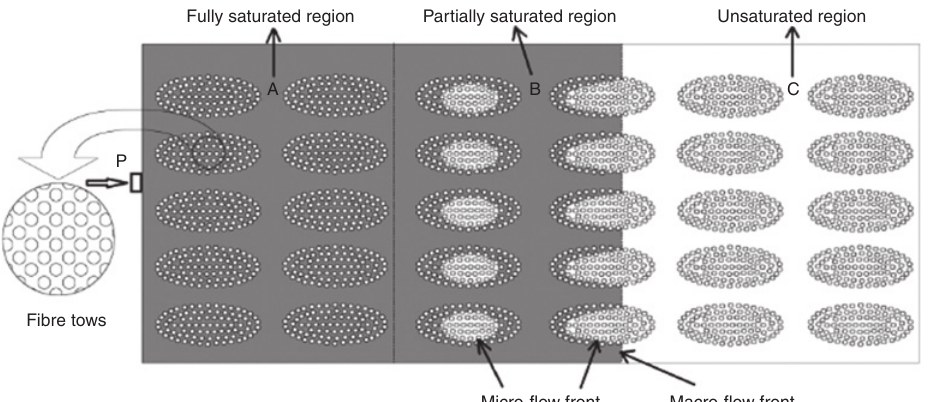
Figure 2: Schematic representation of unsaturated flow.